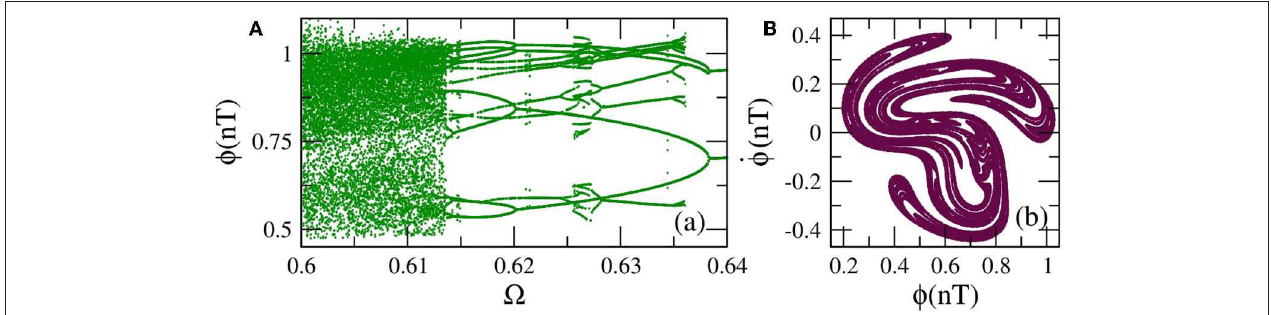
FIGURE 4 | (A) Bifurcation diagram of φ ( nT ) as a function of the driving frequency (cid:127) , for β L attractor on the φ